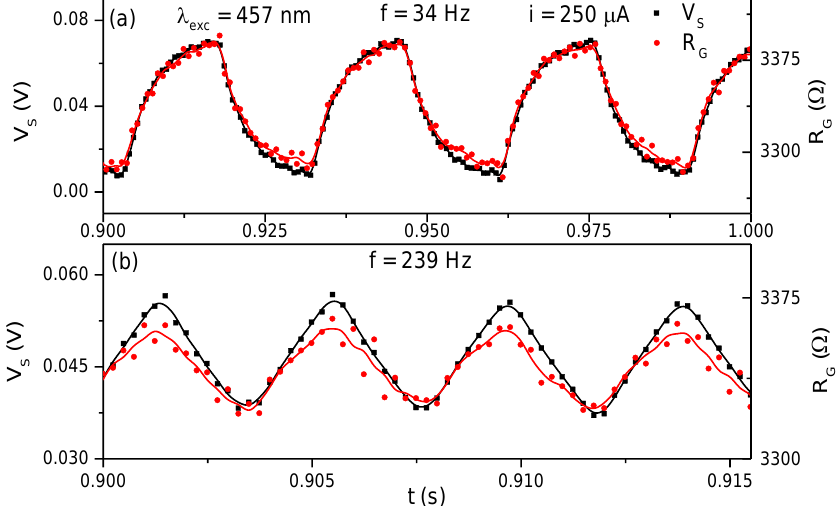
Figure 5. Seebeck open-circuit voltage and the grid resistance measured while the light was chopped at 34 Hz ( a ) and 239 Hz ( b ). The red and black lines are only an eye guide.